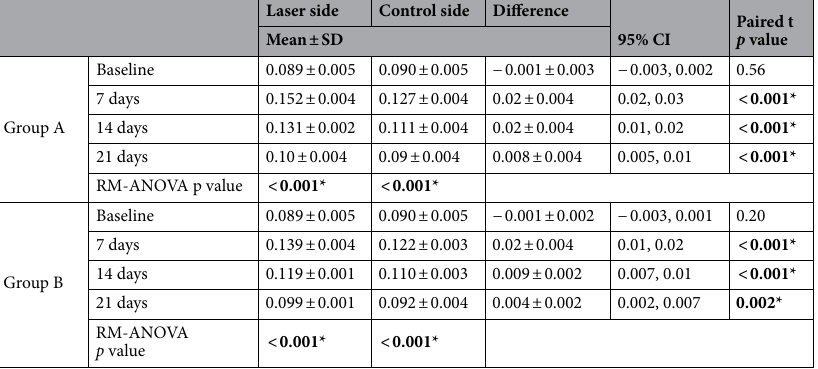
Table 5. Comparison of IL-1β levels (pg/ml/60 s) between the laser and control sides at different time points, in the two study groups. SD Standard deviation, CI Confidence interval, RM‑ANOVA Repeated measures ANOVA. *Statistically significant at p value < 0.05.